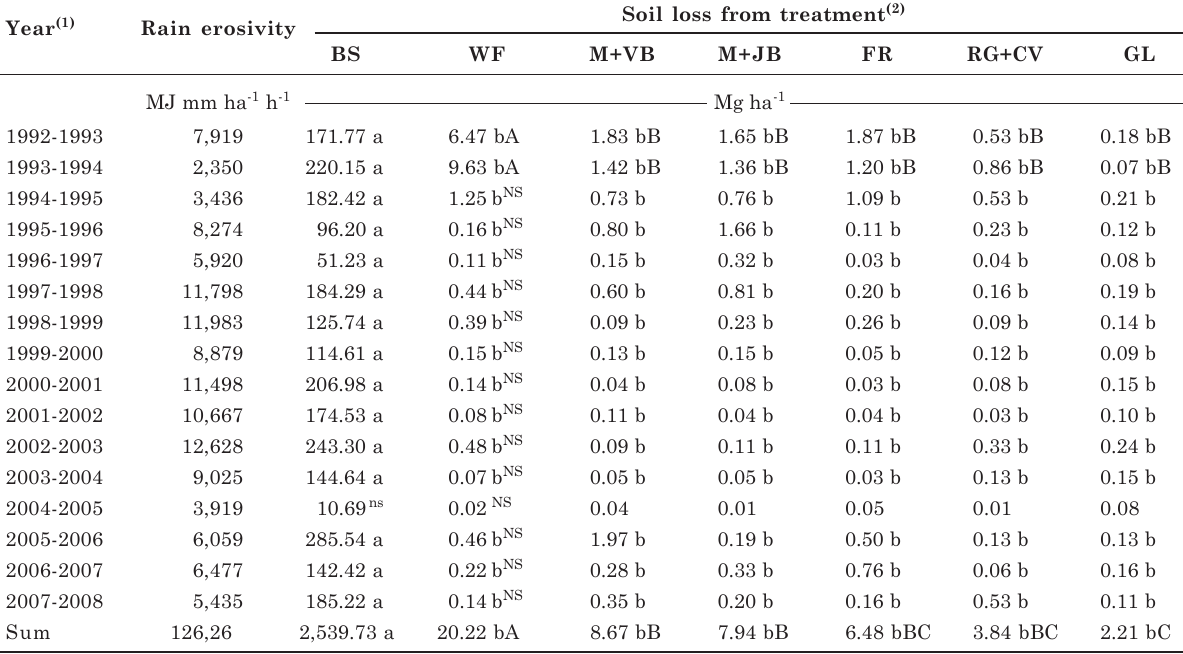
(1) Corresponding to the period from April of the first year to March of the following year. (2) BS: bare soil; WF: winter fallow; M+VB: intercrop maize - velvet bean; M+JB: summer consortium maize - jack bean; FR: forage radish; RG+CV: winter consortium ryegrass - common vetch; GL: grassland. Means followed by the same lowercase letter in the same year are not different by the LS means test (p<0.05) in the comparison among all treatments; means followed by the same uppercase letter in the same year are not different by the LS means test (p<0.05) in the comparison of treatments WF, M+VB, M+JB, FR, RG+CV, and GL; ns n ot significant by the F test (p>0.05) in the comparison among all treatments; NS Not significant by the F test (p>0.05) in the comparison of the treatments WF, M+VB, M+JB, FR, RG+CV, and